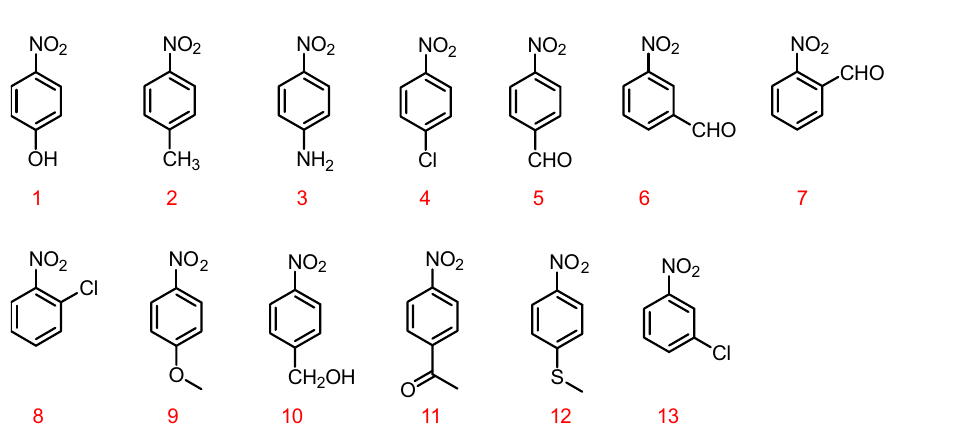
Figure 2. ( a ) N 2 adsorption–desorption isotherms, and ( b ) pore size distribution of FPOP-TPE and S-TPE, calculated from the adsorption branch of isotherms using the NLDFT model. ( c ) TGA curve of FPOP-TPE under nitrogen atmosphere.